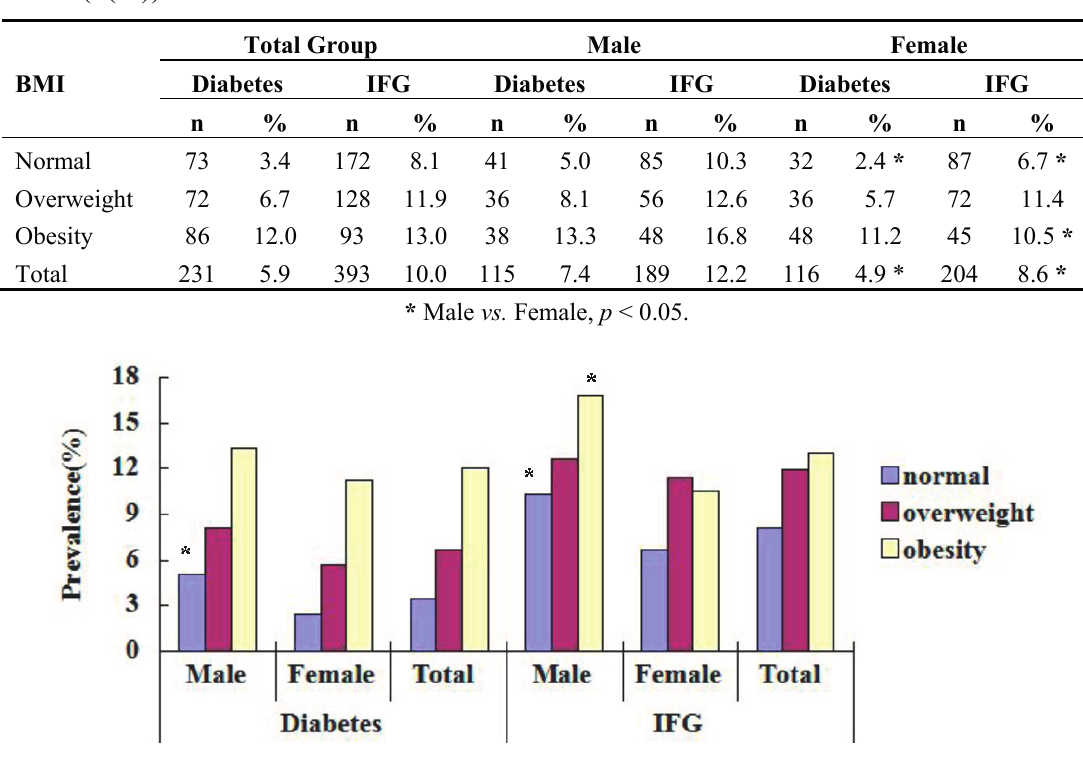
Figure 2. Prevalence of diabetes and fasting glucose (IFG) with different BMI in the Kazakh population in Xinjiang aged ≥ 18 years. * Male vs. Female, p < 0.05 with chi-square test.